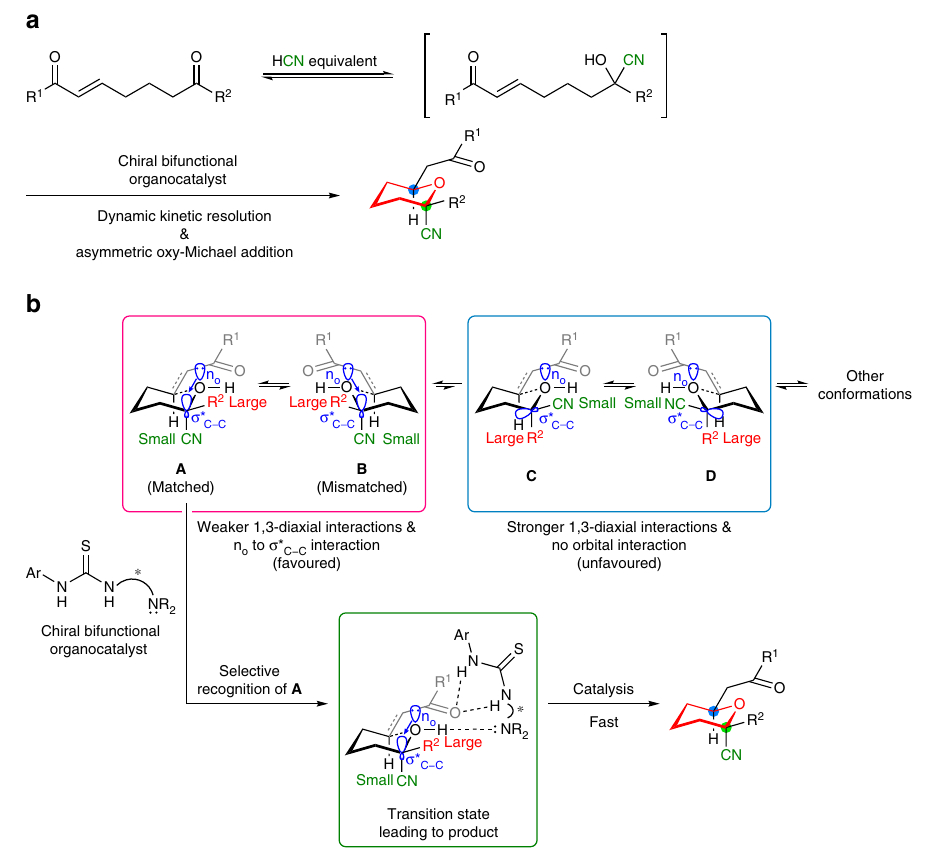
Fig. 2 Reaction design for cycloetheri fi cation via dynamic kinetic resolution. a Intramolecular oxy-Michael addition via dynamic kinetic resolution through reversible generation of chiral cyanohydrins. b Rationale for the proposed